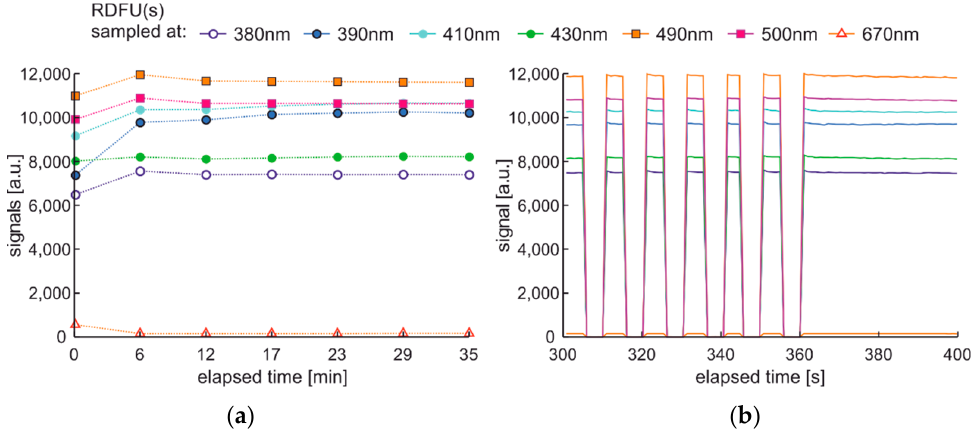
Figure 21. Set of time series of fluorescence data of regular diesel fuel RDFU(s) in cycle DME:UVonToff: ( a ) full-time series; ( b ) zoom of the initial pack.